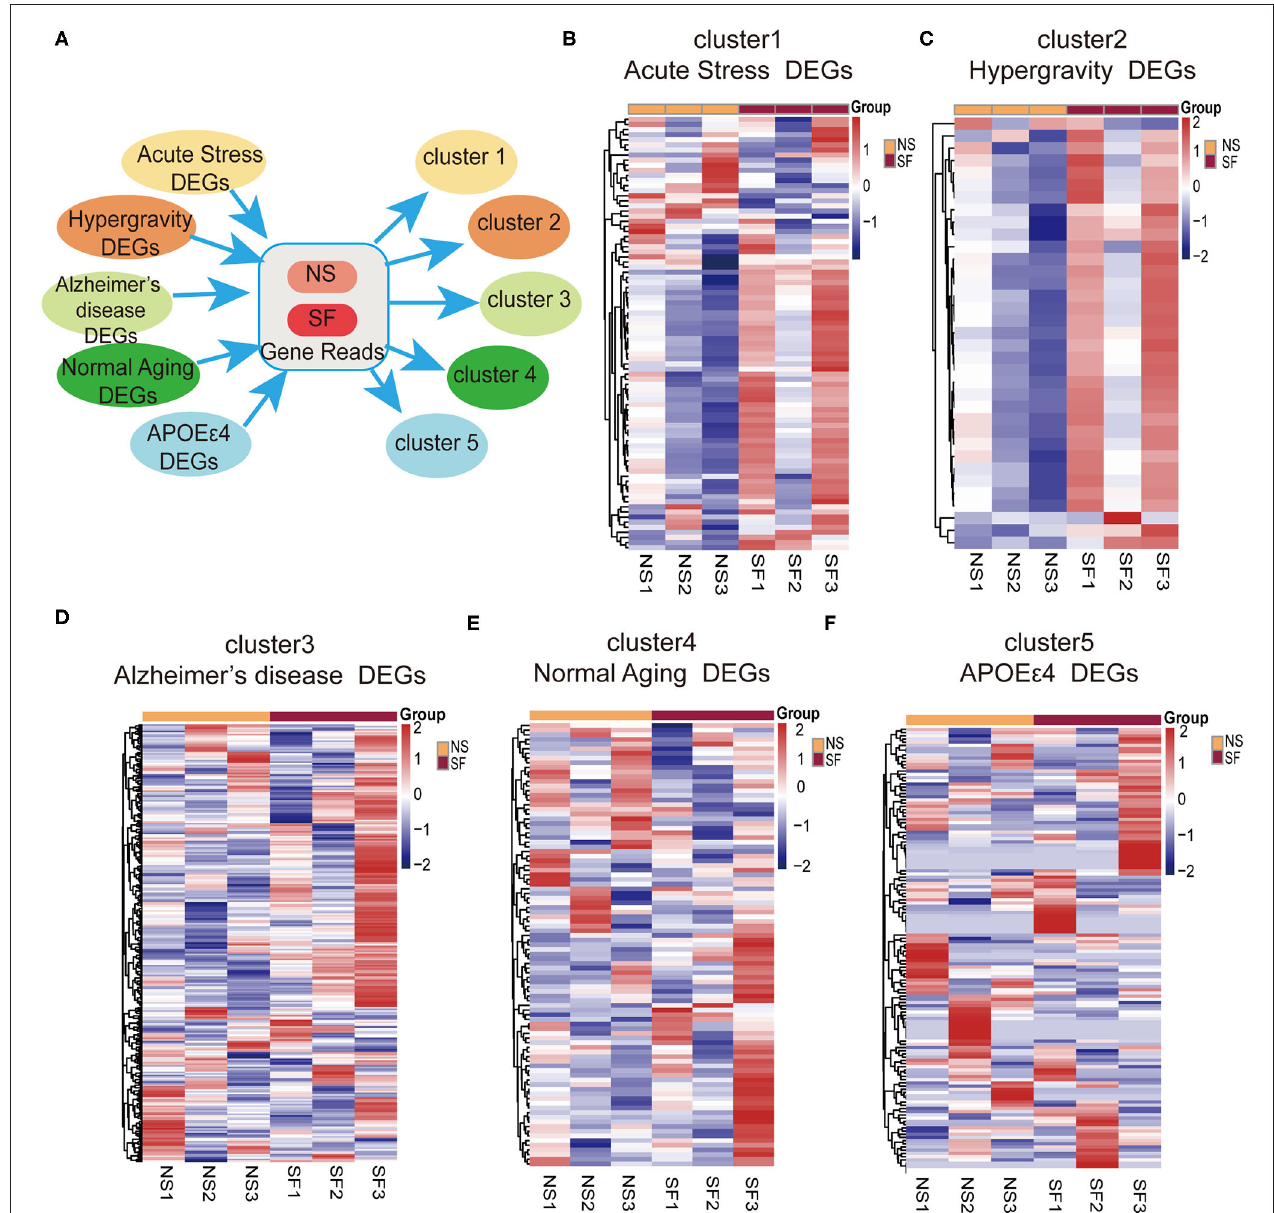
FIGURE 5 | Bioinformatic analysis revealed a link between chronic SF and stress. (A) Schematic instruction of cluster analysis of SF and related diseases or conditions. (B–F) Heat map showing relative gene expression in SF involved in different conditions [ (B) acute stress, (C) hypergravity, (D) Alzheimer’s disease, (E) normal aging, (F) APOE ε 4] n = 3 per